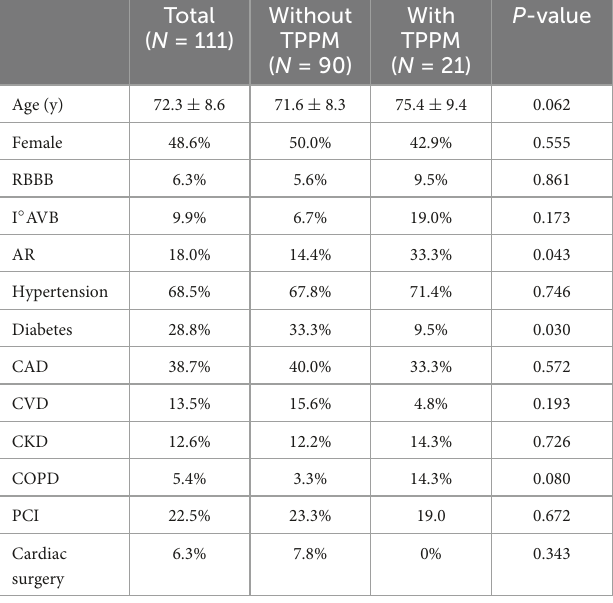
TABLE 1 Baseline characteristics according to the use of temporary permanent pacemaker